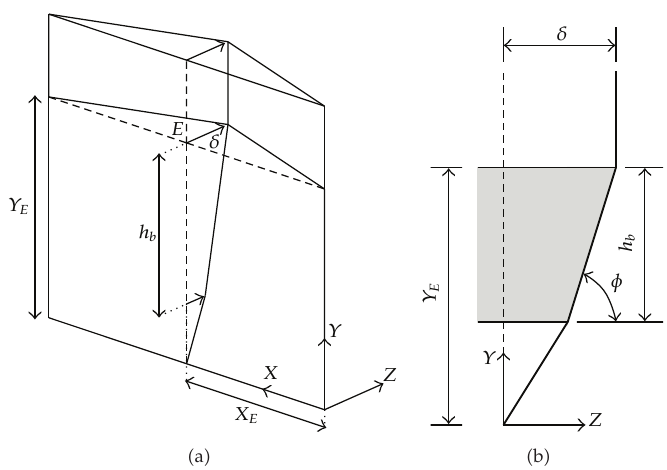
Figure 18: Assumed displacements field after second contact between the bow and the